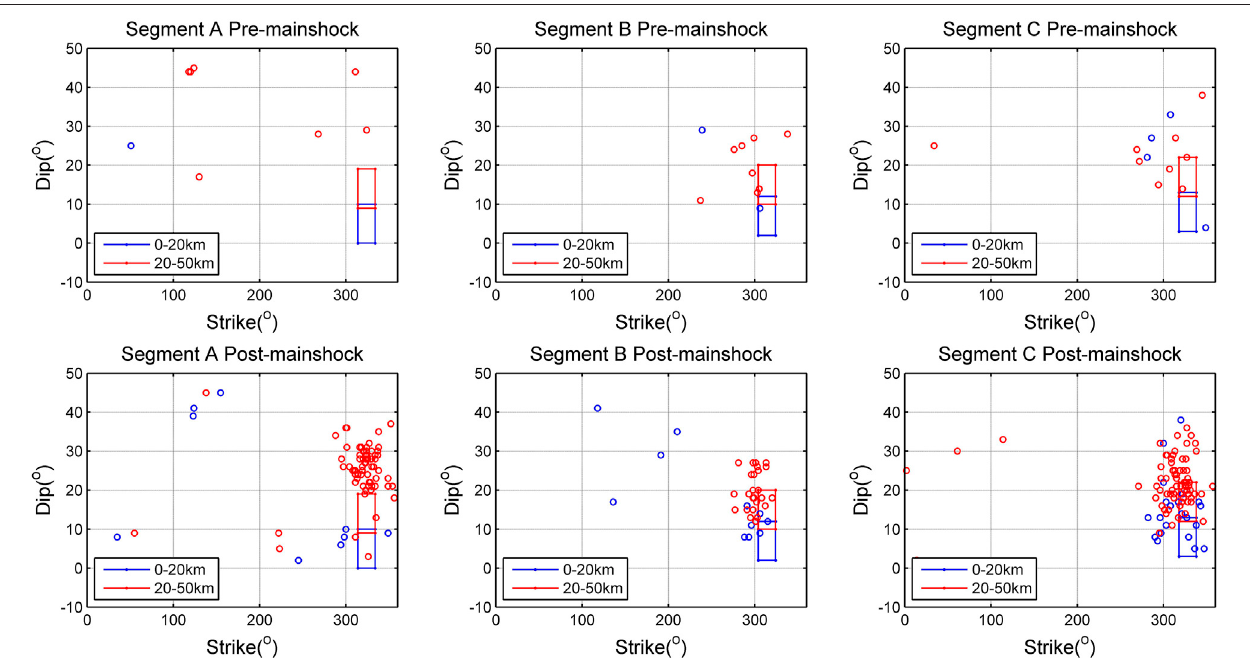
FIGURE 7 | Distribution of strike and dip of the most shallow-dipping nodal plane of each thrust mechanism for pre- and post-mainshock. The shallow-dipping nodal planes of thrust event are divided into 0 – 20 km (blue circles) and 20 – 50 km (red circles) depth interval. The blue and red boxes represent the zone of megathrust geometry orientation for 0 – 20 km and 20 – 50 km depth interval,